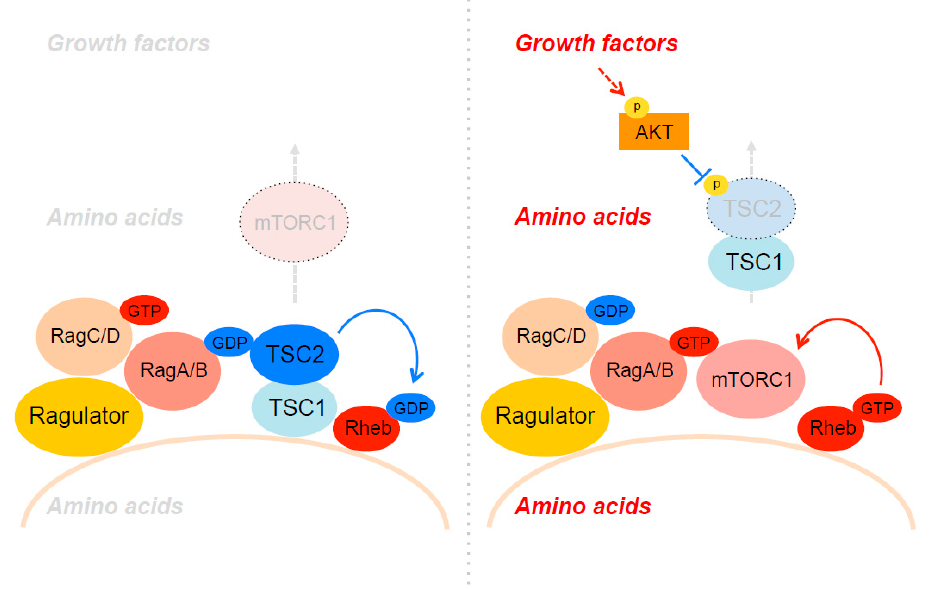
Figure 2. Spatial regulation of the tuberous sclerosis complex (TSC) complex on the lysosomes.The